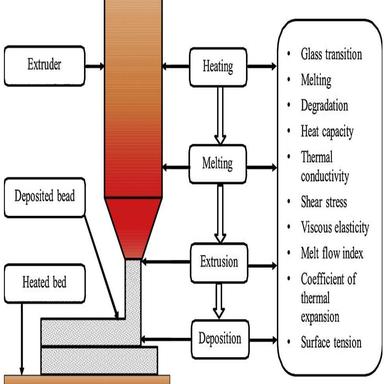
Typical fused filament fabrication process diagram and related thermophysical properties involved during the thermal events.